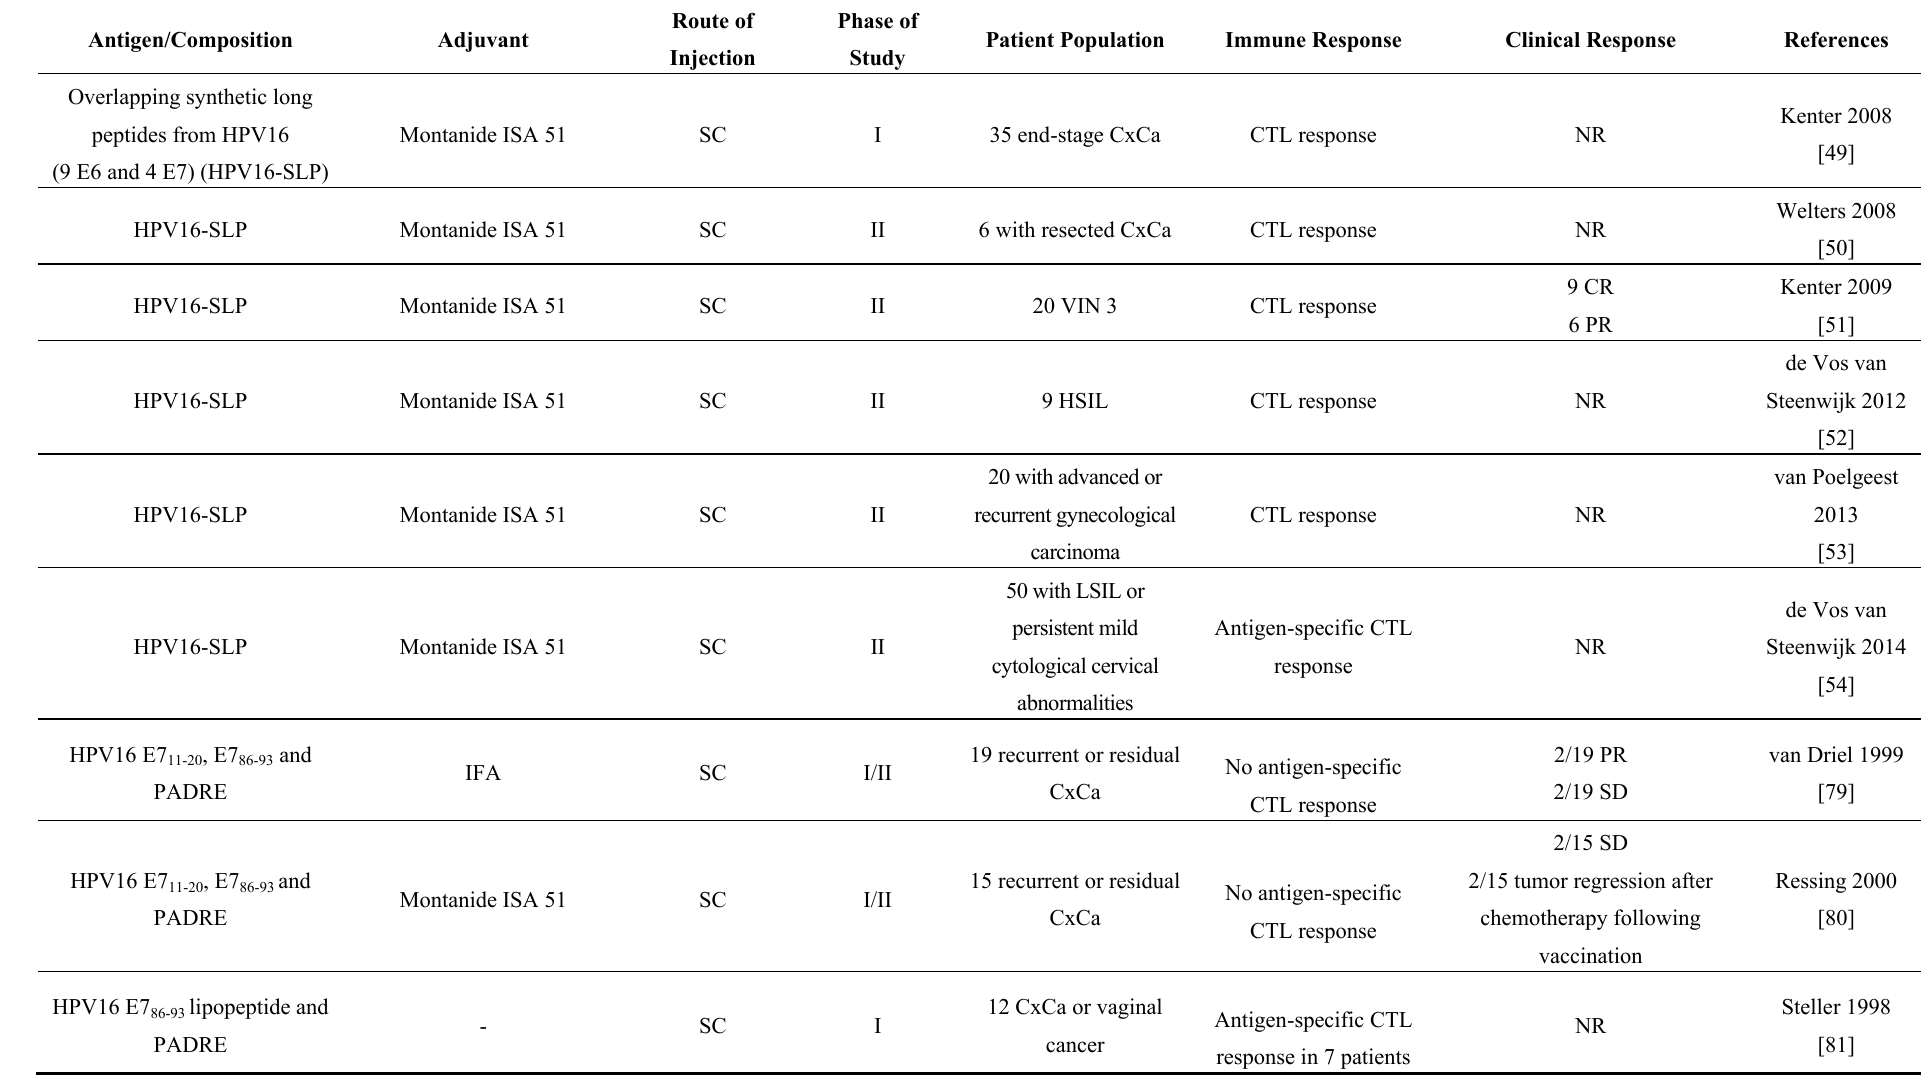
Table 2. Clinical studies with peptide-based